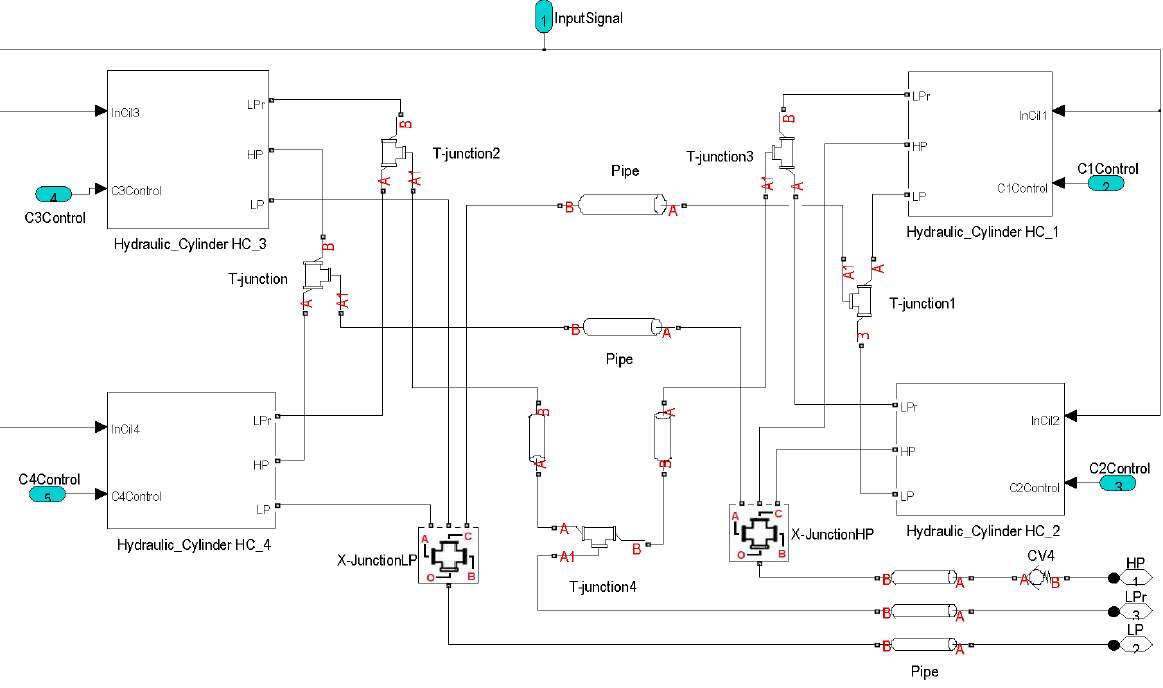
Figure 3. Hydraulic cylinders array